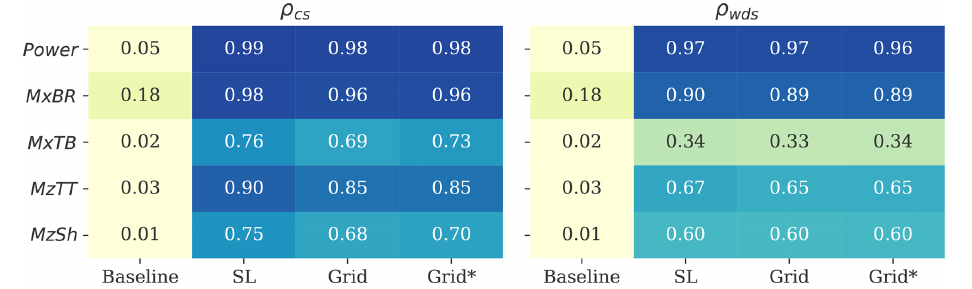
Figure 14. Average cross-correlation coefficient ( ρ ) computed between the reconstructed and target load time series from all the 162 simulations. Results from the CS fields are shown in the left panel, and those from the WDS fields are shown in the right panel.